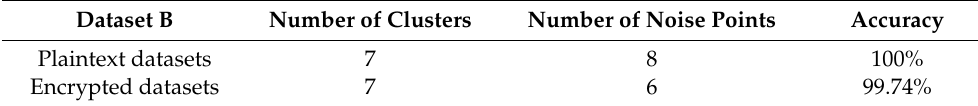
Table 3. Comparison of plaintext and ciphertext clustering results for dataset B. Dataset B Number of Clusters Number of Noise Points Accuracy Plaintext datasets Encrypted